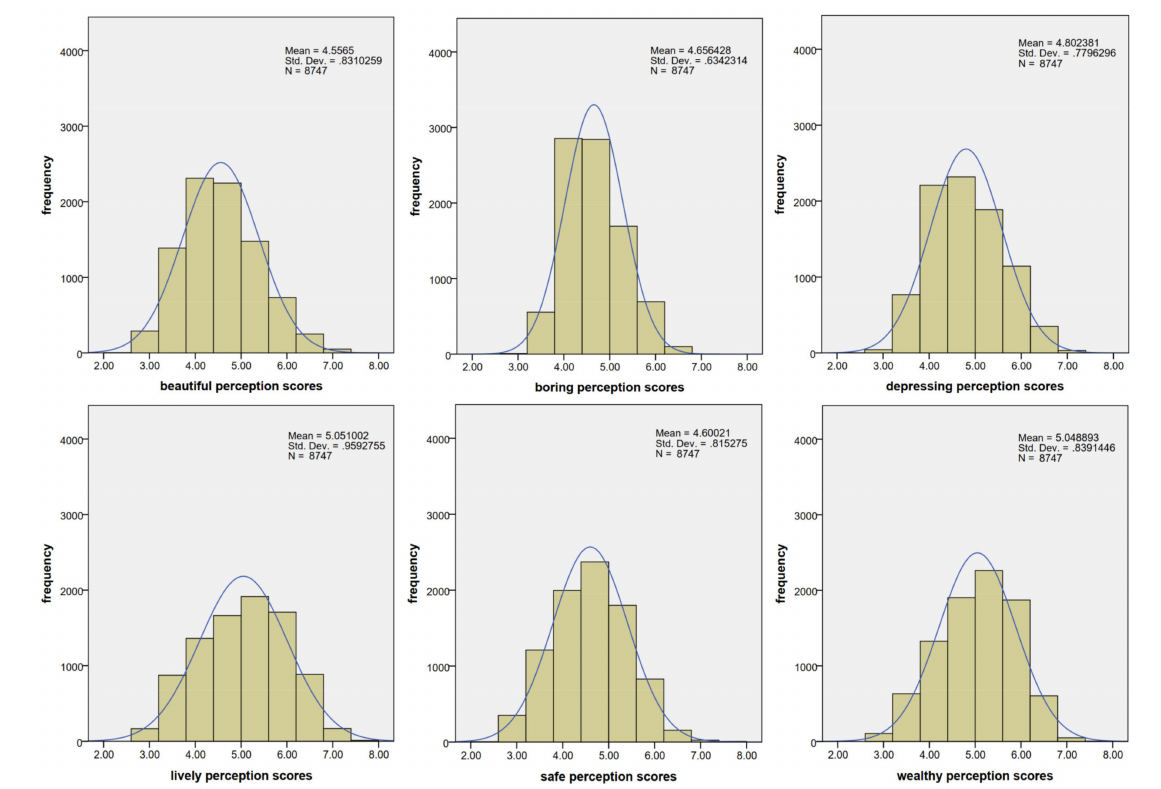
Figure 8. Histogram distribution of human perceptions of Beijing.